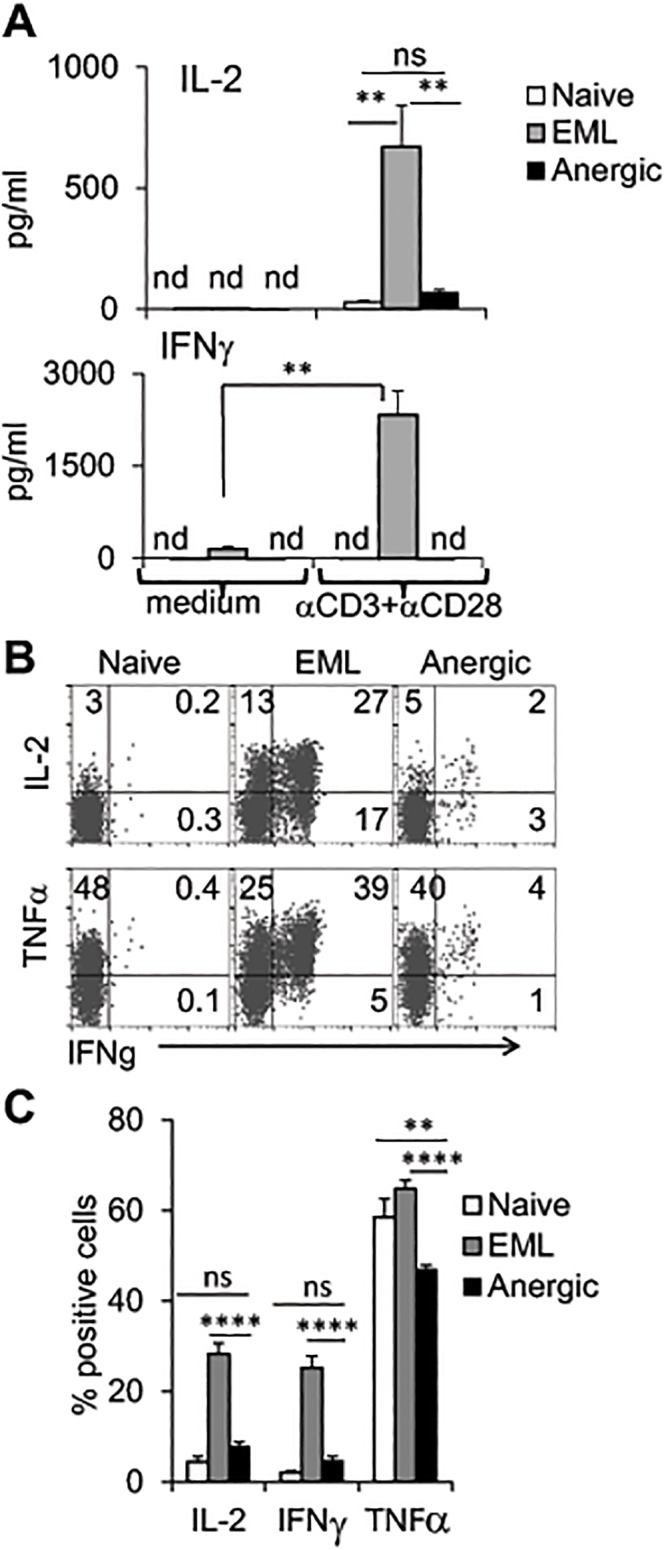
Anergic cells have a defect in cytokine production.
A-B. Naïve CD4+ cells were activated as in Fig 1, purified, and rested in the medium for 4–5 days. A. Purified and rested (4 days) naïve, EML, and anergic cells were activated with plate-bound αCD3 and soluble αCD28 for 24 hours in the presence of αCD25 + αCD122 to prevent IL-2 usage. ELISA for the indicated cytokines was performed, and data are presented as mean ± SD of 3 independent experiments (**p<0.01; nd, not detected; ns, not significant). B-C. Cells were treated with PDBU and ionomycin in the presence of monensin for 2 hours. The intracellular staining of cytokines was evaluated by FACS. C. Average percentage of cytokine-positive cells from a group of 16 naïve, 39 EML, and 39 anergic cell samples (**p<0.01, ****p<0.0001). The data are presented as mean ± SEM.